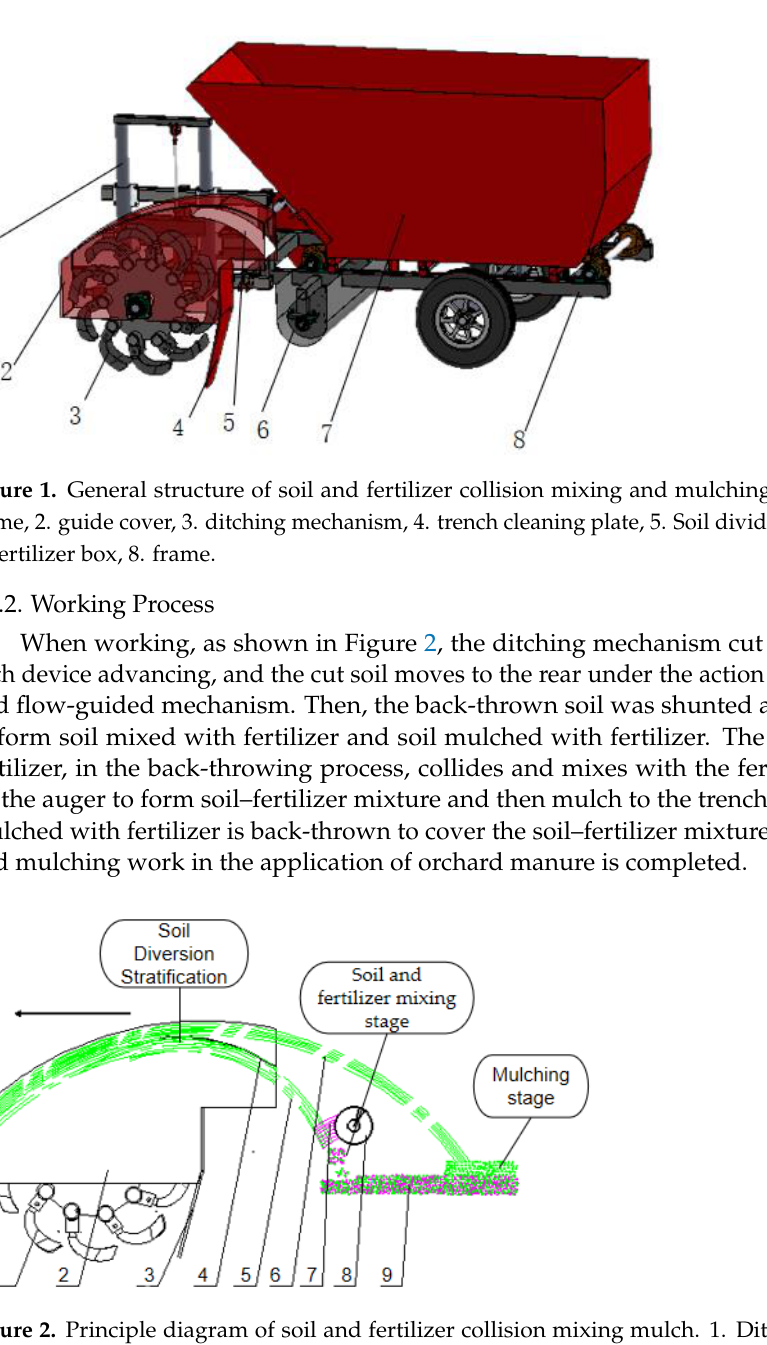
Figure 2. Principle diagram of soil and fertilizer collision mixing mulch. 1. Ditching mechanism, 2. Deflector, 3. Ditch cleaning plate, 4. Soil dividing plate, 5. Back-throwing fertilizer mixing soil particles, 6. Back throwing of soil particles covered with fertilizer, 7. Manure particles, 8. Auger, 9. Soil fertilizer mixing layer.